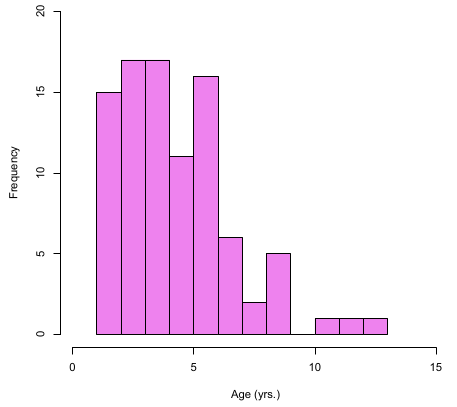
Table 1. Incidence rate (expressed in infections per 100 animal-month at risk) and its 95% confidence interval of BLV infections, for the groups Adult Cows and Young Animals, by Farm.